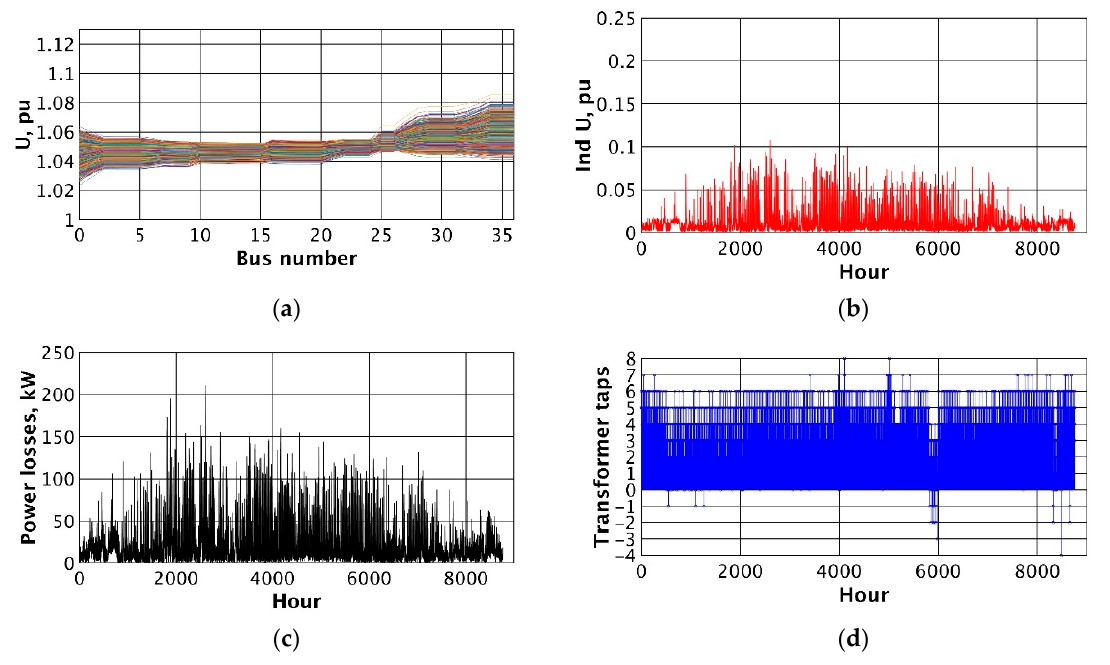
Figure 10. Results of the analysis of the effects of voltage regulation using the OPFh-MVt method: ( a ) voltage values in the network nodes for all hours of the year, ( b ) annual changes in the voltage quality index, ( c ) annual changes in power losses in the network, ( d ) annual changes in the position OLTC.